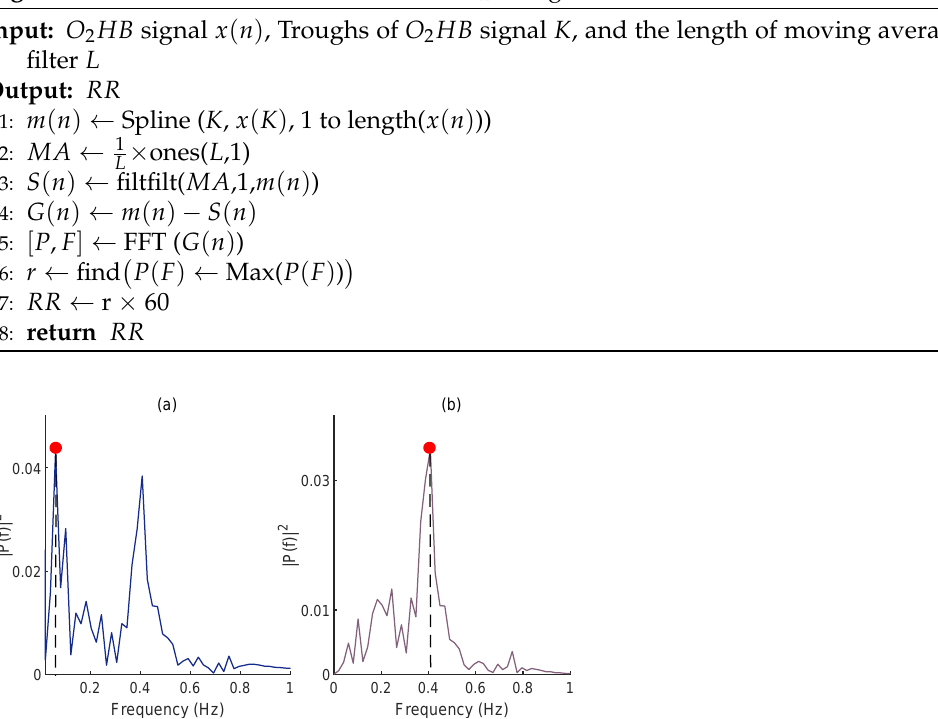
Algorithm 2 Estimation of the RR from the O 2 Hb signal’s baseline wander